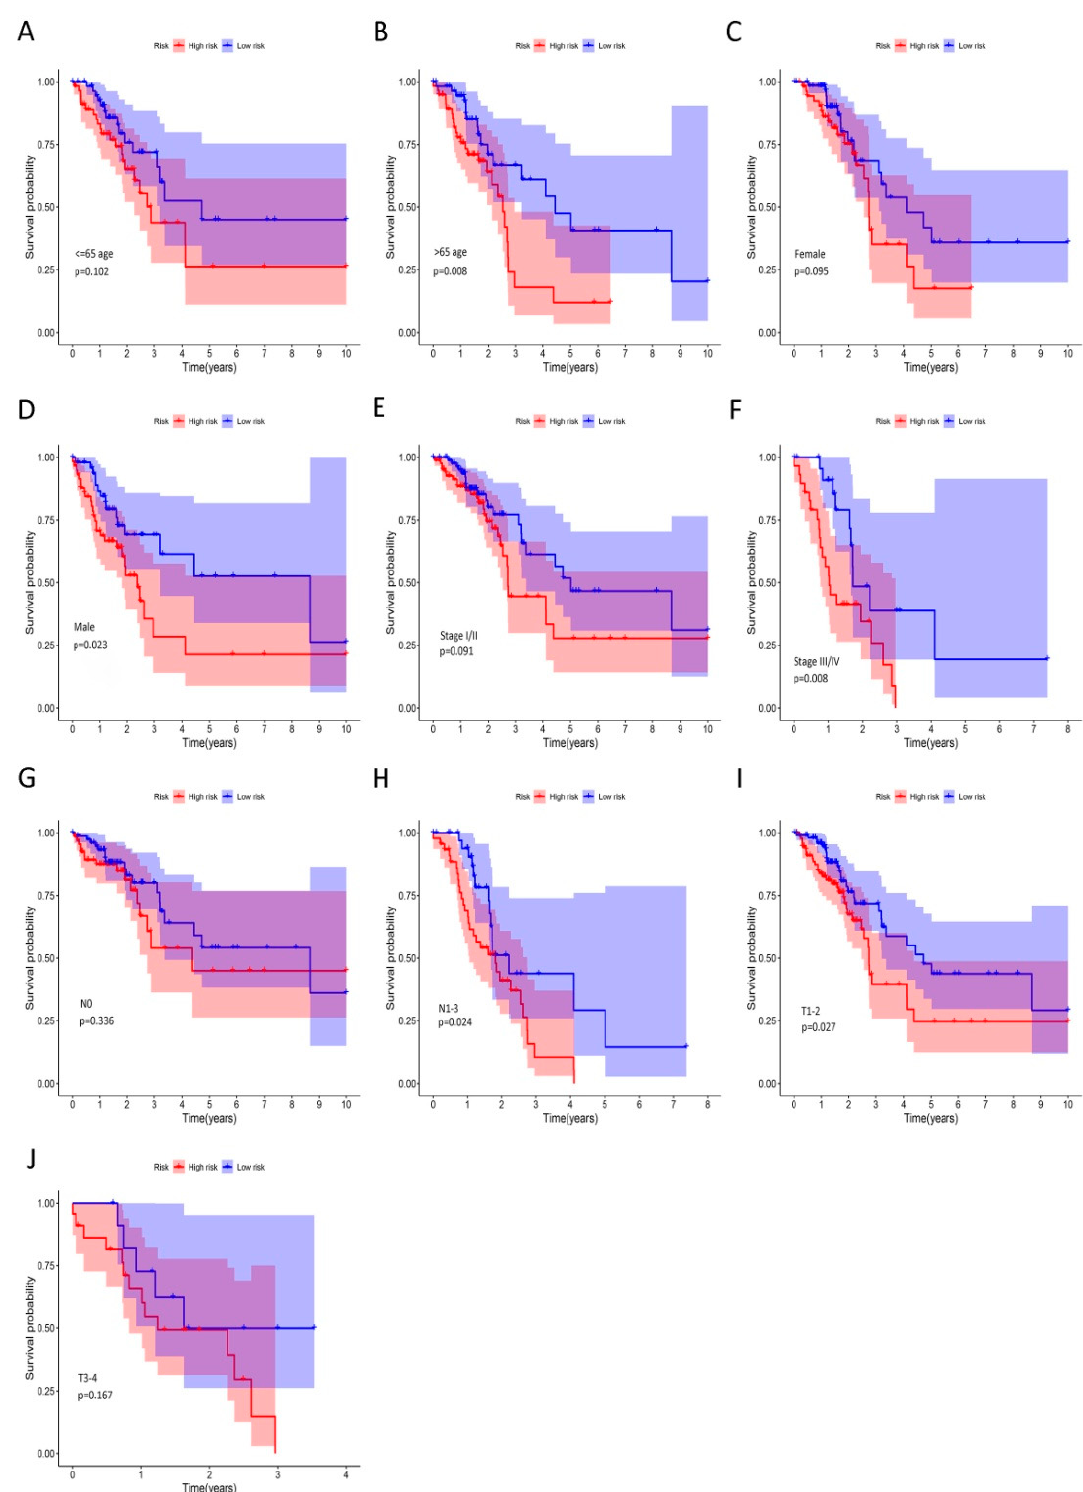
Figure 6. The prognostic value of riskscore signature in LUAD. ( A – J ) Kaplan–Meier curves for OS in patients with LUAD; clinical characteristics include age: ≤ 65 ( A ) and > 65 ( B ), gender: female ( C ) and male ( D ), clinical stage I / II ( E ) and III / IV ( F ), lymph node metastasis: N0 ( G ) and N1-3 ( H ), and primary tumor: T1-2 ( I ) and T3-4 ( J ). Male, > 65 age, stage III / IV, N1-2 and T1-2 subgroups were significantly associated with worse OS in high-risk group with respective p <